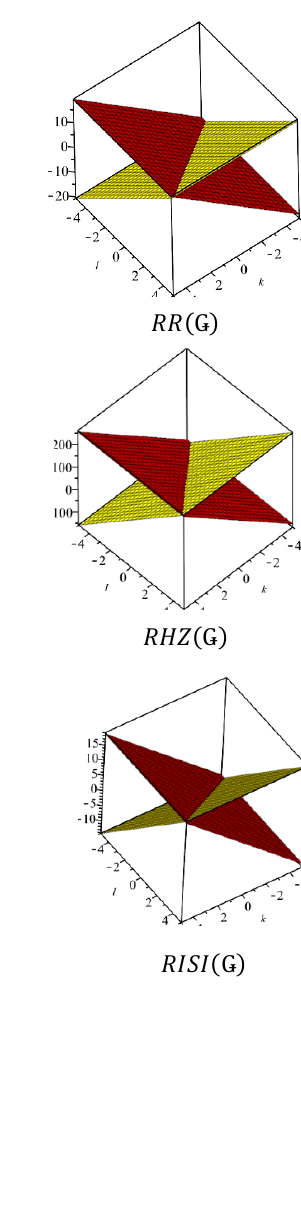
Figure 9 . 3D plots when ( 𝑙 = 1, 𝑘 > 1) and ( 𝑙 > 1, 𝑘 = 1). Case 4. When 𝑙 = 1, 𝑘 = 1, the reverse edge partition of the graphene contained only 𝑟𝑚 (cid:2869),(cid:2869) = 6 edges, and by the definition of reverse general inverse sum indeg descriptor, 𝑅𝐺 (cid:3010)(cid:3020)(cid:3010)